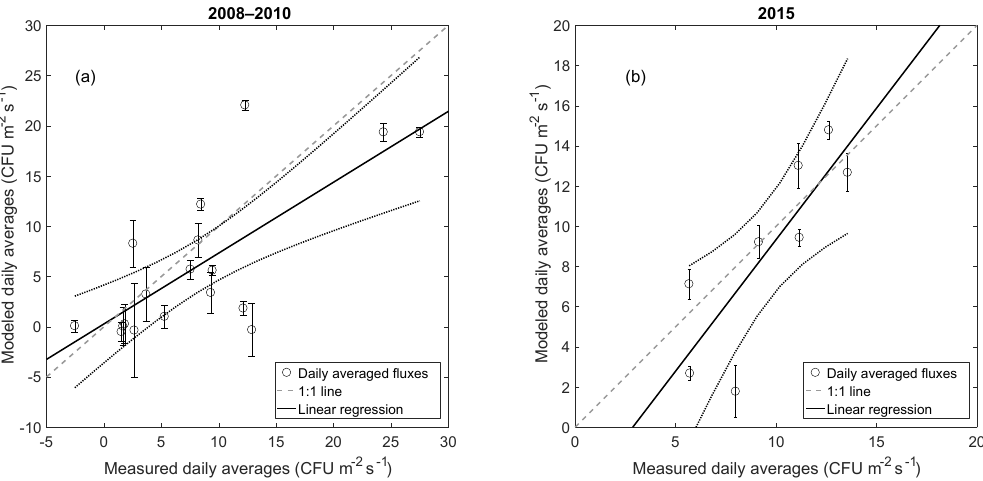
Figure 7. Relationship between measured and modeled daily averages of microbial flux. Figure 6a shows the regression between the daily averages from the 2008–2010 campaigns and the optimized model ( y = 0 . 70 x + 0 . 28; r 2 = 0 . 54) and Fig. 6b shows the one from the 2015 campaigns and the model ( y = 1 . 31 x − 3 . 75; r 2 = 0 . 68). The error bars are derived from the following equation: ± σ the standard deviation of the ratio between the difference between modeled and observed points (m i − o i ) and the average of the same points (m i ,o i ) .